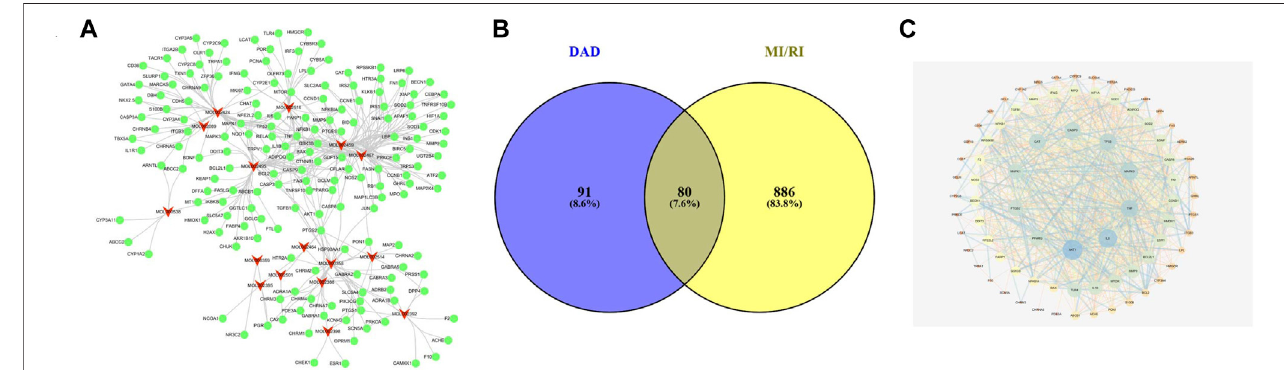
FIGURE1| Thenetworksofdriedgingerandaconitedecoctionanti-MI/RI. (A) Thecompound-targetnetworkofDAD.Therednodesrepresentactivecompounds and the green nodes represent targets. The target surrounding the active components are proportional to their degree. (B) Overlap of DAD and MI/RI targets. The blue circlesrepresentDADtargetsand theyellow circles represent MI/RItargets. Theshaded areaisthetargetofDAD anti-MI/RI. (C) Theprotein-proteininteractionnetwork of protein targets obtained from STRING database and constructed by Cytoscape. The colors of the nodes are illustrated from blue to yellow to orange in descending order of degree values.